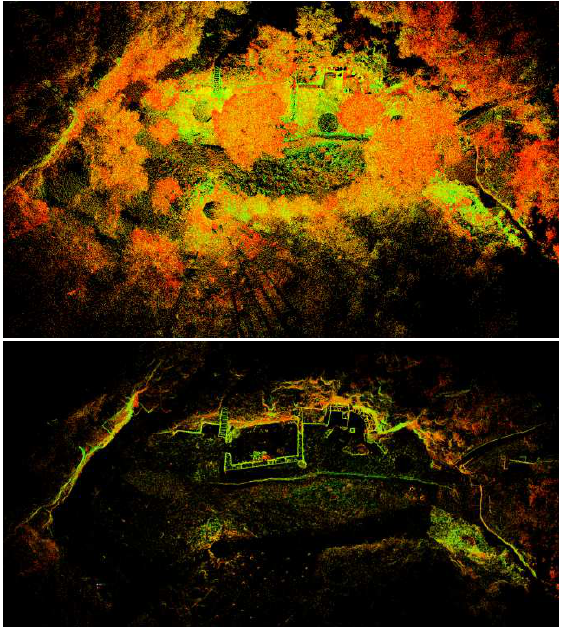
Figure 5. The kitchen area: the original point cloud (top) and the post-processed vegetation free data